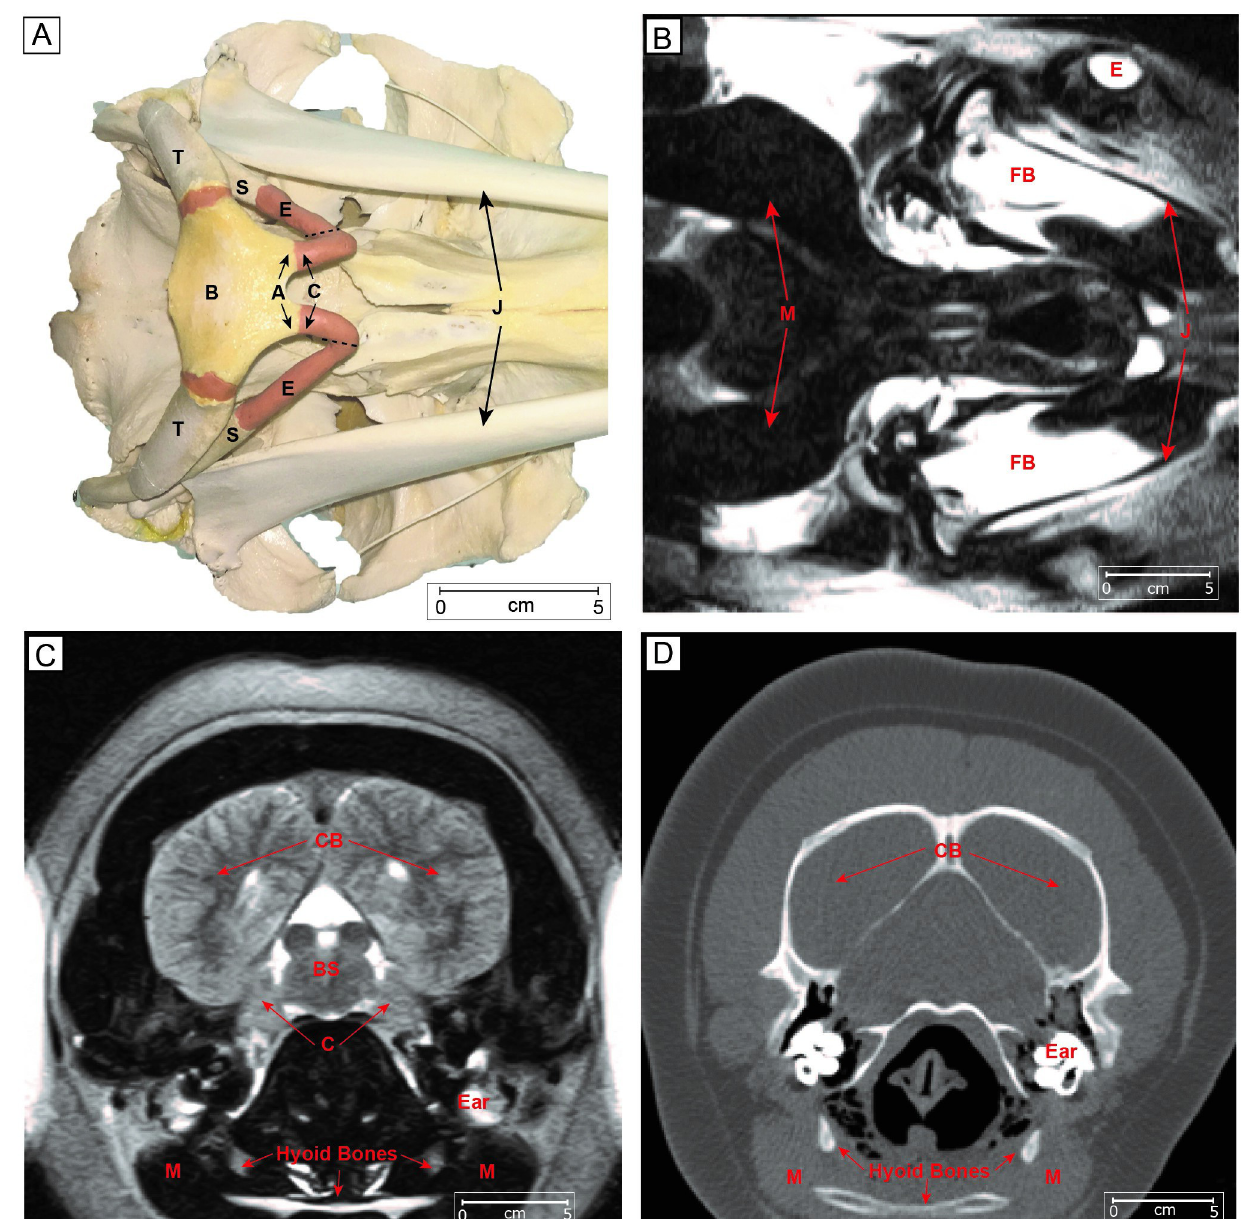
Fig 7. Bones and muscles related to the hyolingual apparatus of bottlenose dolphins. A. Ventral view of a dolphin skull. A, articular process; B, basihyal; C, ceratohyal; E, epihyal; S, stylohyal; T, tympanohyal; J, mandible. Hyoid bone terminology from Reidenberg and Laitman [38]; B. Horizontal MRI image viewed at the level of the stylohyal showing the heavy (dark) musculature. FB, fat body of lower jaw, E eye, J jaw. C. Frontal MRI image displaying anterior portions of brain and hyoid apparatus. C, cerebellum; CB, cerebrum; BS, brainstem, Ear, M, muscle masses of hyoid area. D. Frontal CT scan shows hyoid bones and immense musculature adjacent M. (MRI and CT scans are reconfigured and relabeled from [40].